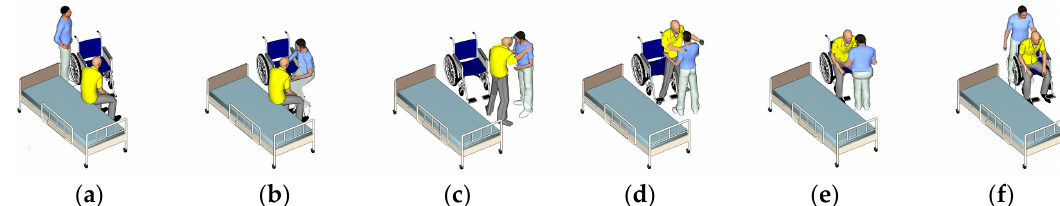
Figure 2. Patient transfer skills of ( a ) sitting on the bed; ( b ) mutual hugging; ( c ) standing up; ( d ) pivot turning; ( e ) sitting down on the wheelchair; and ( f ) final posture adjustment.